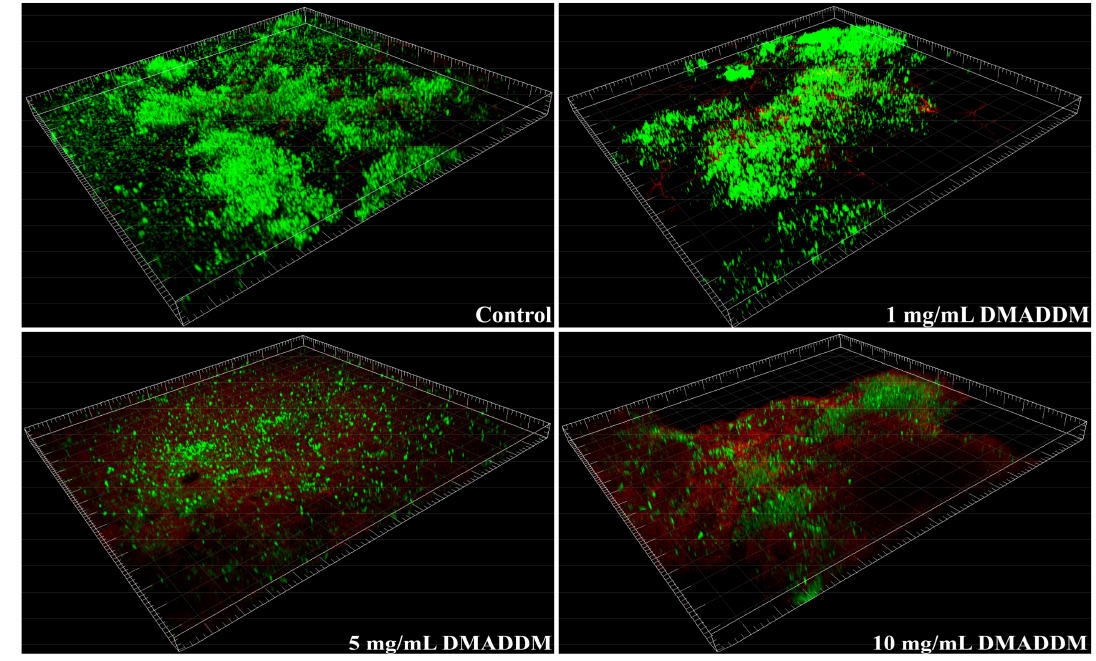
Figure 2. Confocal laser scanning microscope (CLSM) of saliva-derived biofilms. Live/dead staining of biofilms on the titanium discs of the four groups. Live cells were stained green, and dead cells were stained